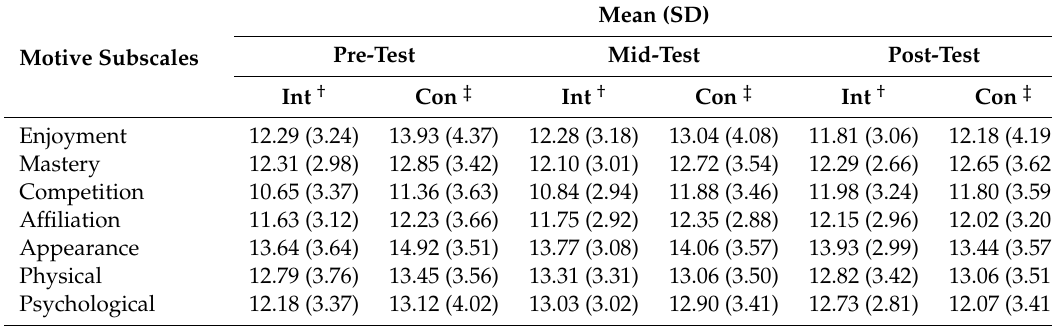
Table 2. Mean (SD) for each motive subscale.